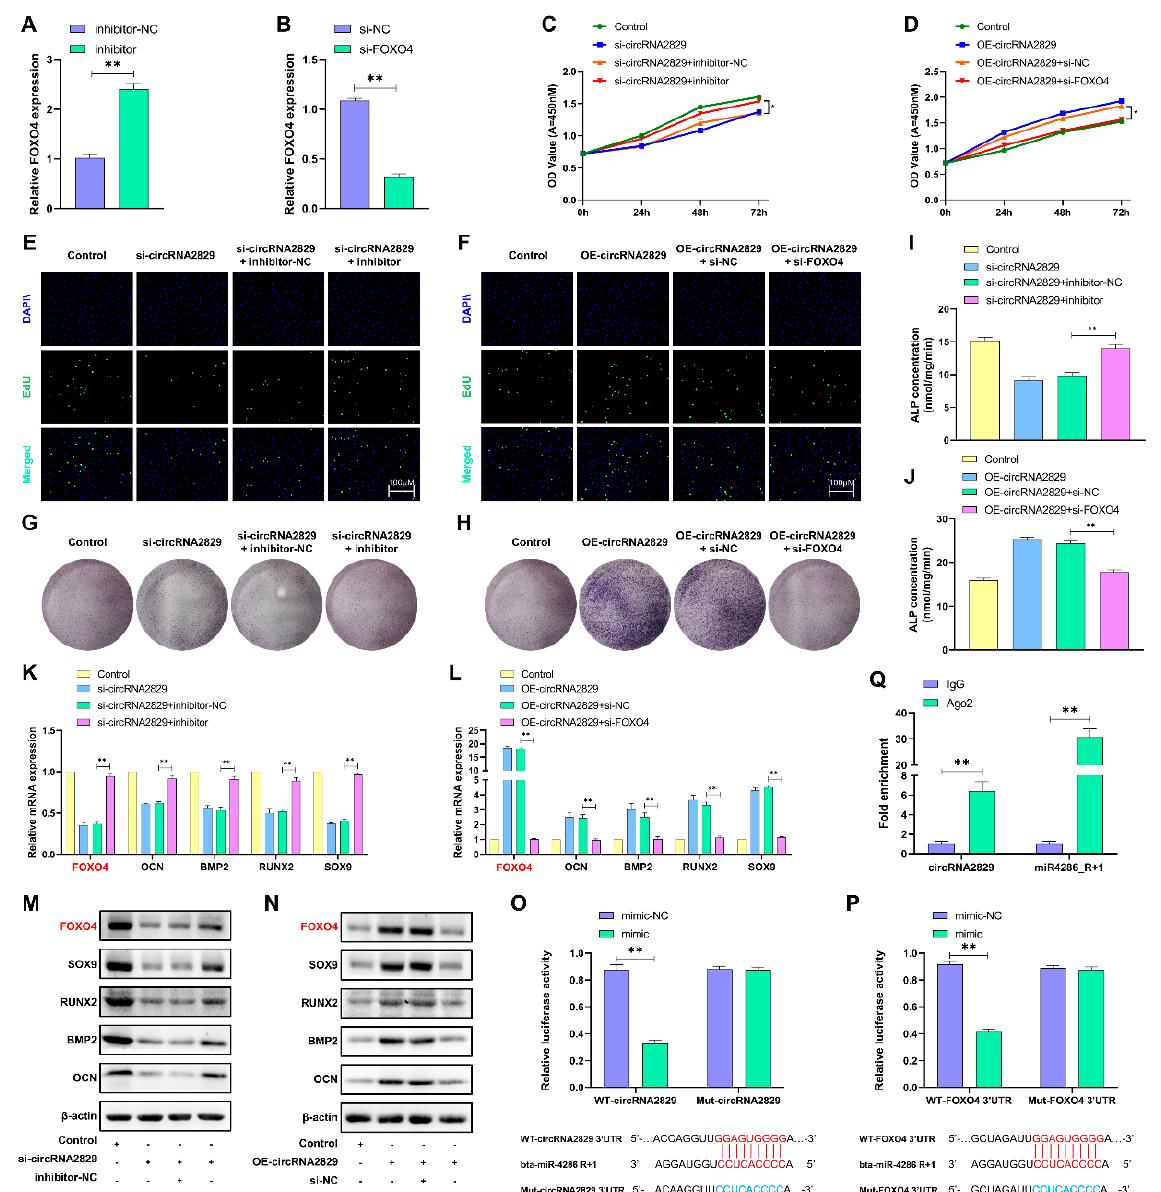
Figure 8. circRNA2829 promotes chondrocyte proliferation and differentiation via the miR4286- R+1/FOXO4 axis. ( A , B ) RT-qPCR to detect changes in FOXO4 expression levels in chondrocytes after transfection with inhibitor or si-FOXO4. After cotransfection of si-circRNA and inhibitor or cotransfection of OE-circRNA and si-FOXO4 in chondrocytes, cell proliferation ability was measured by CCK-8 ( C , D ) and EdU ( E , F ); osteogenic differentiation ability of chondrocytes was assessed by BCIP/NBT staining ( G , H ) and ALP viability assay ( I , J ); RT-qPCR ( K , L ) and Western blotting ( M , N ) were used to detect changes in the mRNA and protein of osteogenic marker-related genes. ( O , P ) Dual luciferase reporter gene assay to demonstrate the binding site of miR-4286-R+1 to circRNA2829 and FOXO4; ( Q ) RT-qPCR to detect the expression levels of circRNA2829 and miR- 4286-R+1 in RIP antibody complexes. ** p < 0.01, * p < 0.05. 3. Discussion The differentiation of mesenchymal tissue at the top of the antler into cartilage tissue is a key link in antler regeneration [14]. During antler growth, mesenchymal stem cells